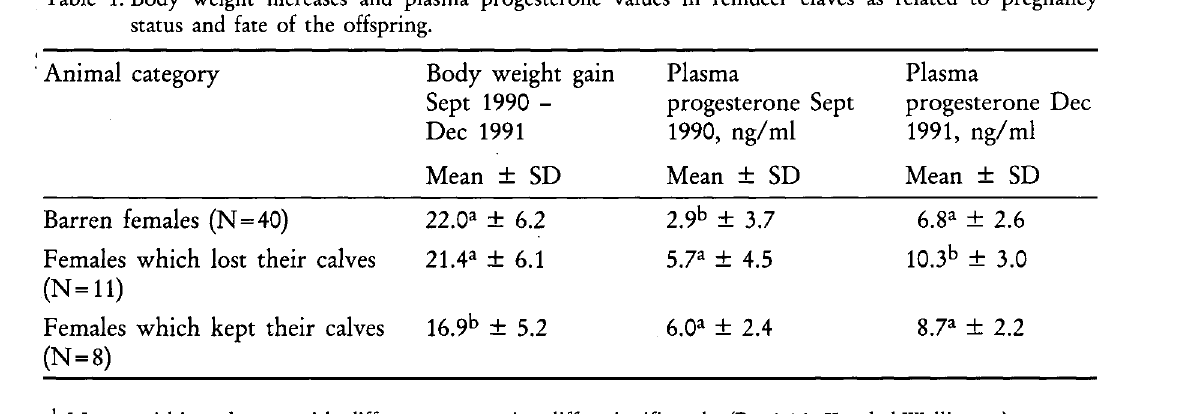
und for progesterone when used as a positive pregnancy test. A discriminatory level between 3.5 and 5 ng progesterone/ml plasma was found to give the best accuracy.